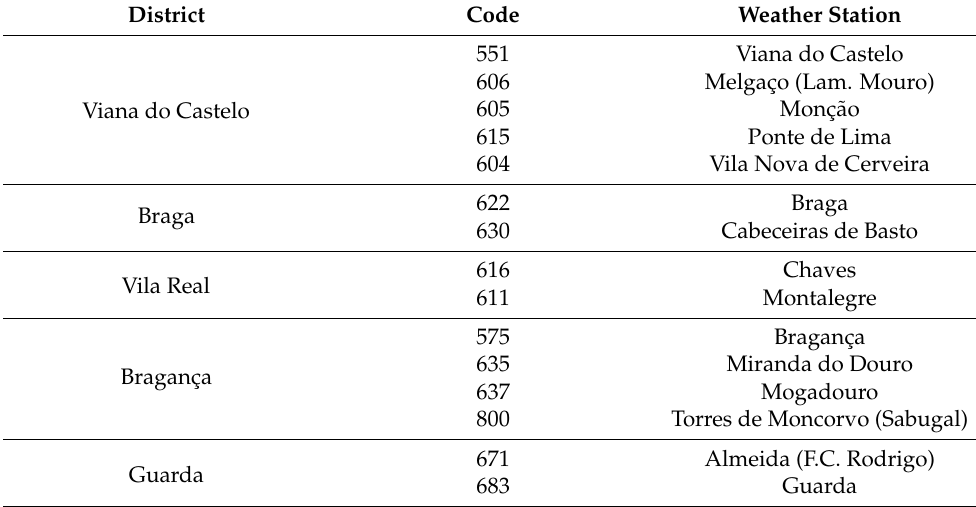
Table A1. Portuguese weather stations used. The code and the meteo station designations are those used by